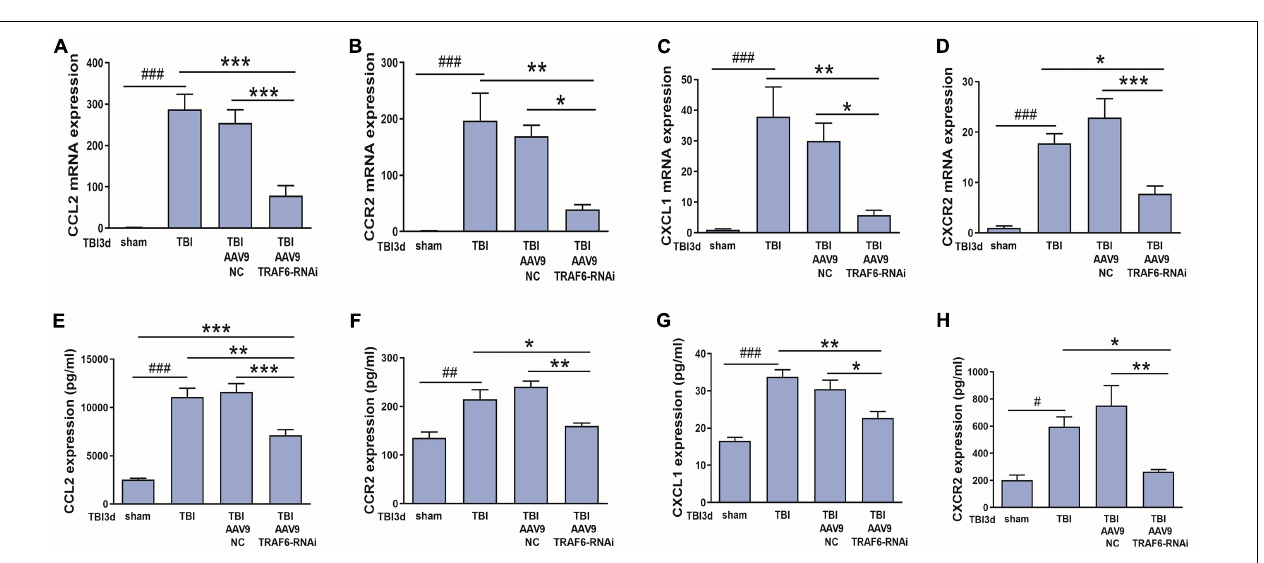
FIGURE 7 | TRAF6 knockdown suppressed CCL2, CCR2, CXCL1, and CXCR2 expression at both mRNA and protein levels in injured cortex after TBI. (A–D) AAV9-TRAF6-RNAi downregulated (A,B) CCL2 and CCR2 mRNA, (C,D) CXCL1 and CXCR2 mRNA, (E,F) CCL2 and CCR2 protein, and (G,H) CXCL1 and CXCR2 protein expression in injured cortex on day 3 post-TBI. * P < 0.05, ** P < 0.01, and *** P < 0.001 vs. AAV9-TRAF6-RNAi group. # P < 0.05, ## P < 0.01, and ### P < 0.001 vs. sham